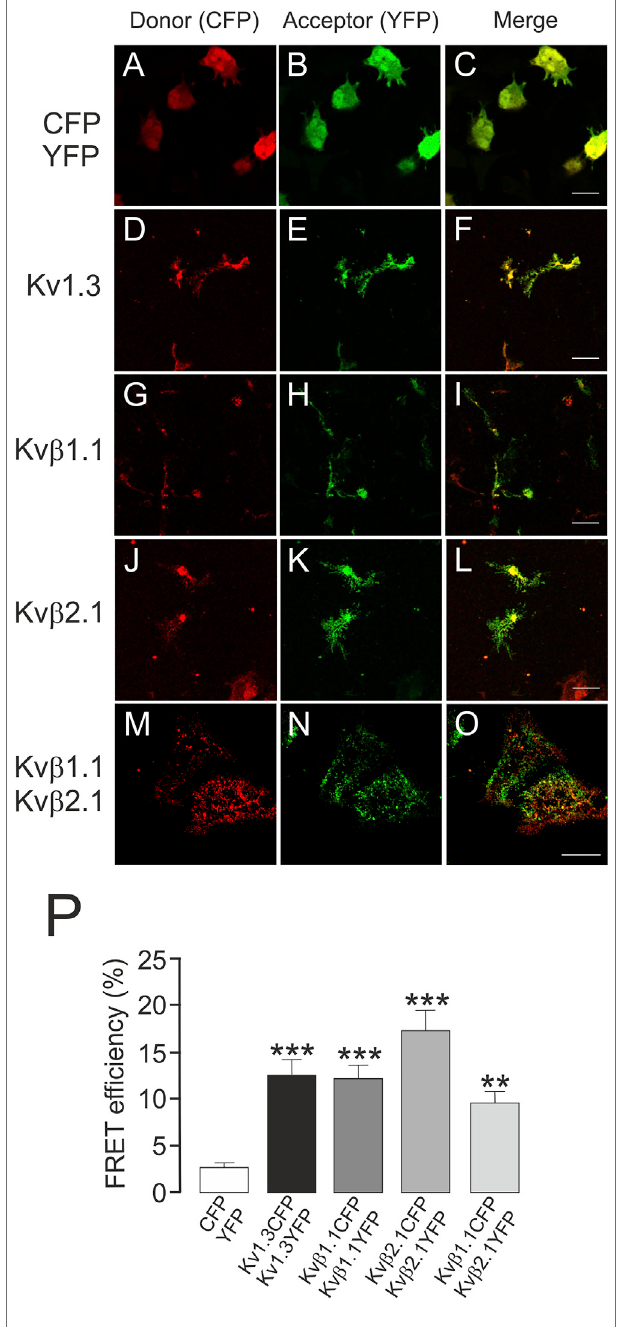
FIGURE 6 | Kv β 1.1 and Kv β 2.1 form heteromeric complexes at the plasma membrane. HEK 293 cells were transfected with Kv1.3YFP- Kv1.3CFP, Kv β 1.1YFP-Kv β 1.1CFP and Kv β 2.1YFP-Kv β 2.1CFP. After transfection, CUPs were puri fi ed, and FRET was analyzed. (A – C) CFP- YFP-transfected cells were used as negative controls. Note that CFP-YFP was analyzed in entire cells. (D – F) Kv1.3CFP-Kv1.3YFP. (G – I) Kv β 1.1CFP- Kv β 1.1YFP. (J – L) Kv β 2.1CFP-Kv β 2.1YFP. (M – O) Kv β 1.1CFP-Kv β 2.1YFP. Red panels, CFP; green panels, YFP; merged panels, yellow indicates colocalization. (P) FRET ef fi ciency (%). **, p < 0.01; ***, p < 0.001 versus CFP- YFP (Student ’ s t test). Values are the mean of 20 – 30 cells. Scale bars represent 10 µm.